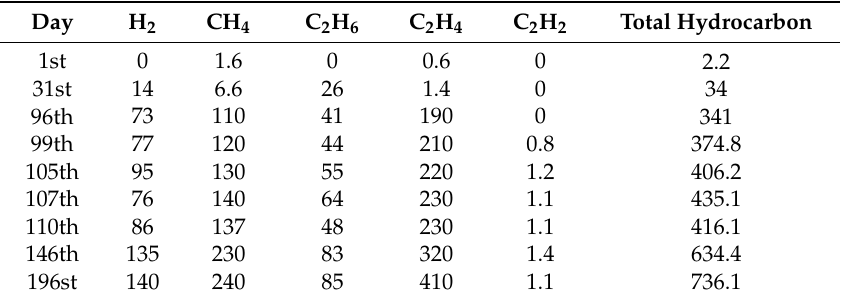
Table 5. The content of the dissolved gas in T2 (uL/L).